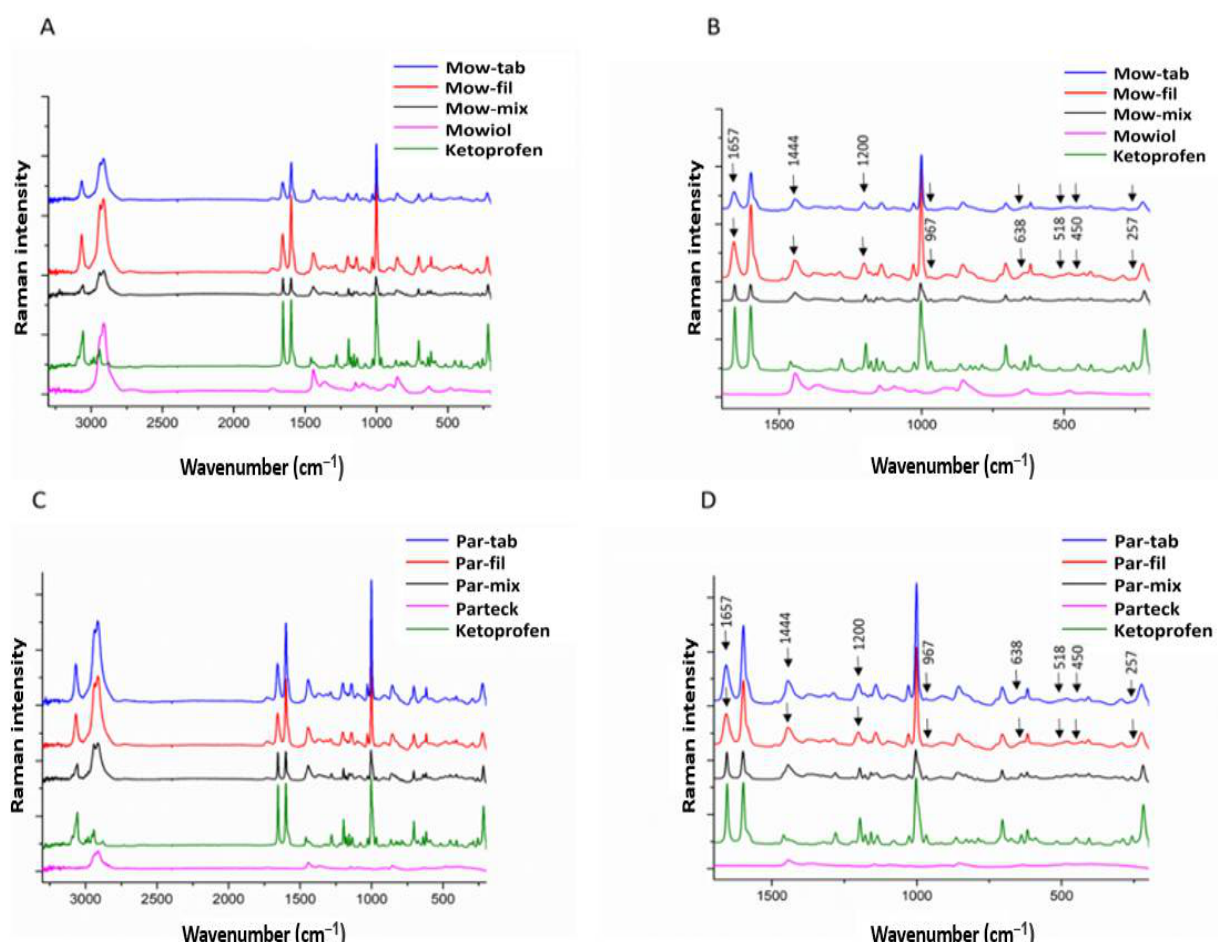
Figure 4. ( A ) Raman spectra of Mow, KET, and Mow-based formulations and ( B ) the magnification of fingerprint range spectrum; ( C ) Raman spectra of Par, KET, and Par-based formulations and ( D ) the magnification of fingerprint range spectrum.